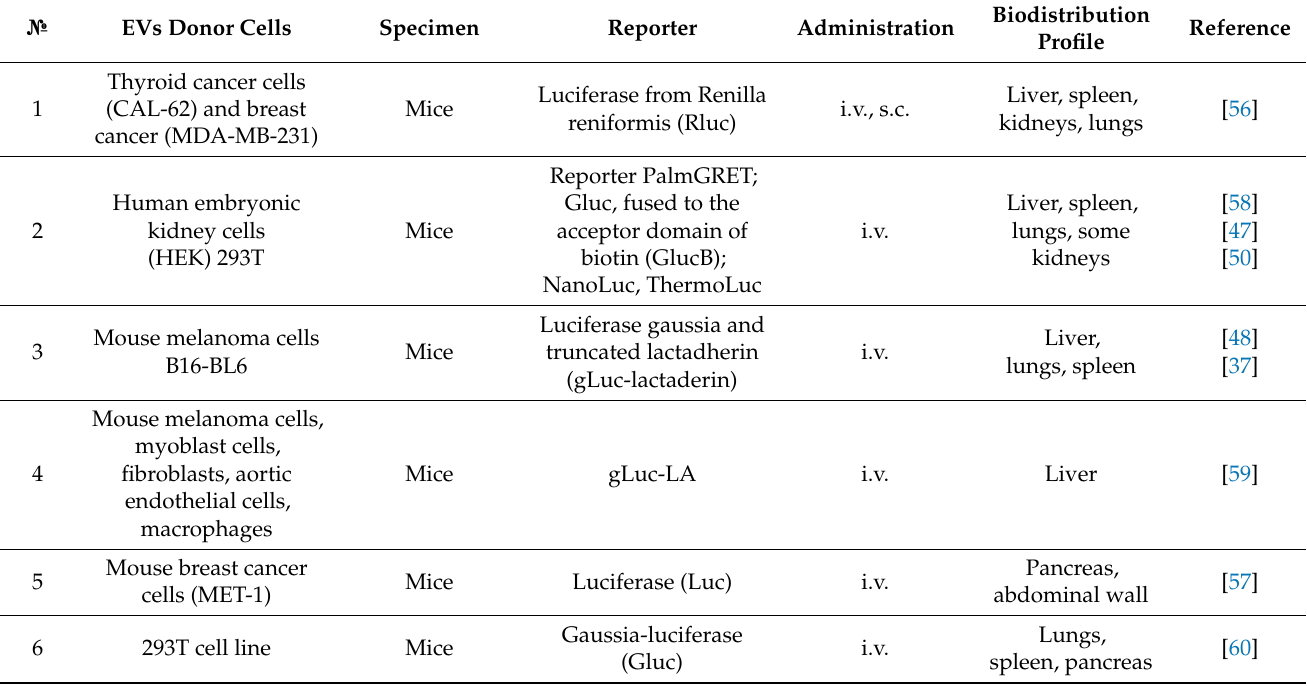
Table 1. The most commonly used bioluminescent tags used to track